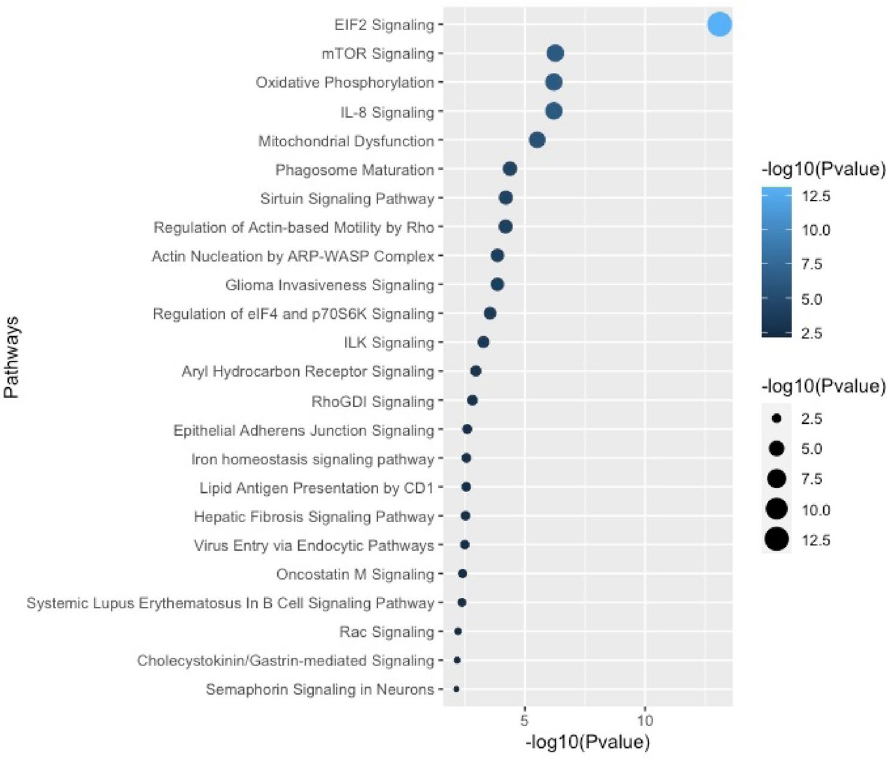
Figure 2. Ingenuity pathway analysis of genes differentially expressed between the total population of control and PAH PAECs. Differential expression analyses revealed 629 genes. These were used for canonical pathway ingenuity analyses.